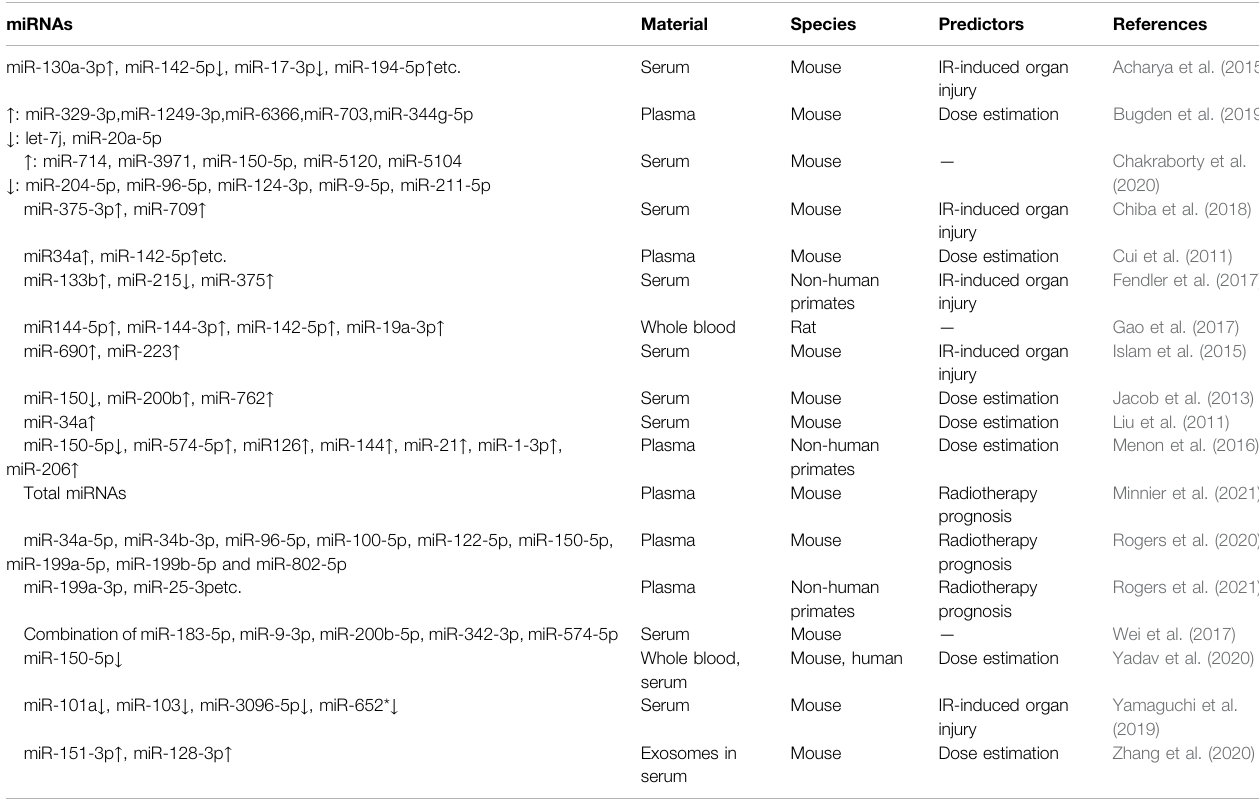
TABLE 2 | Serum or plasma miRNAs as IR biomarkers in animal models.